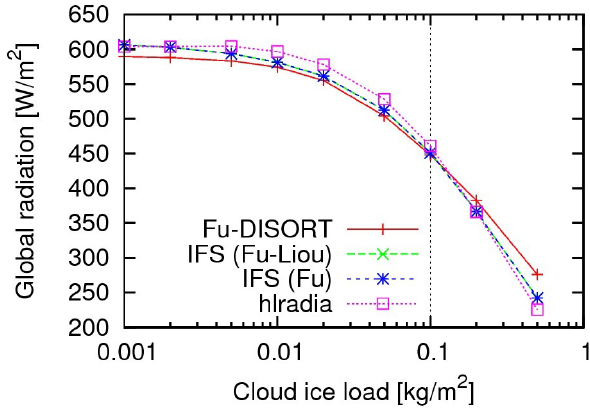
Figure 23. As for Fig. 22 but for albedo=0.7 (experiment